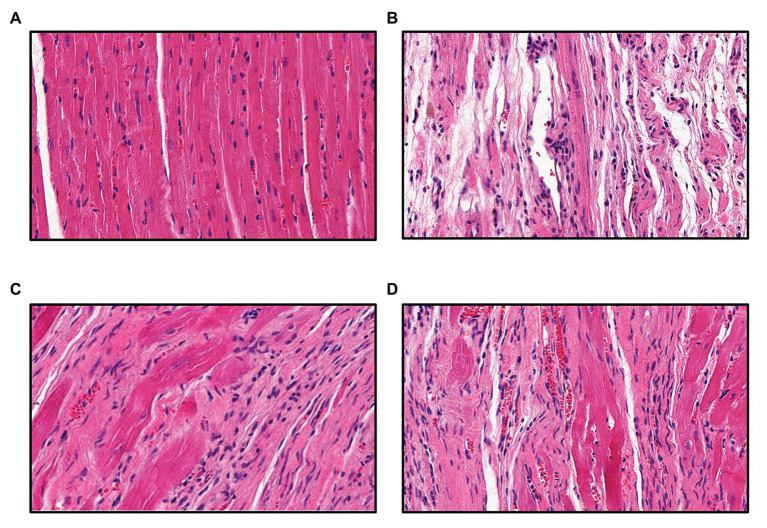
Left ventricular myocardial cell arrangement (HE staining 20 × 10 times). (A) Sham operation group; (B) control group; (C) sodium creatine phosphate group; and (D) Xinmailong group.